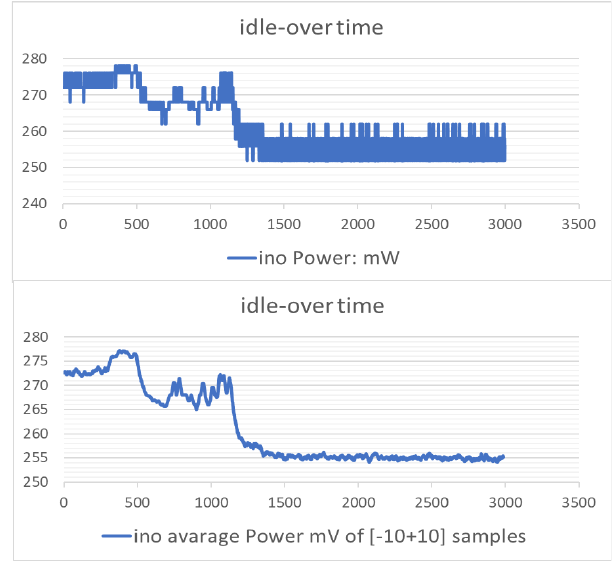
Figure 33. 1 h running Arduino in idle mode.